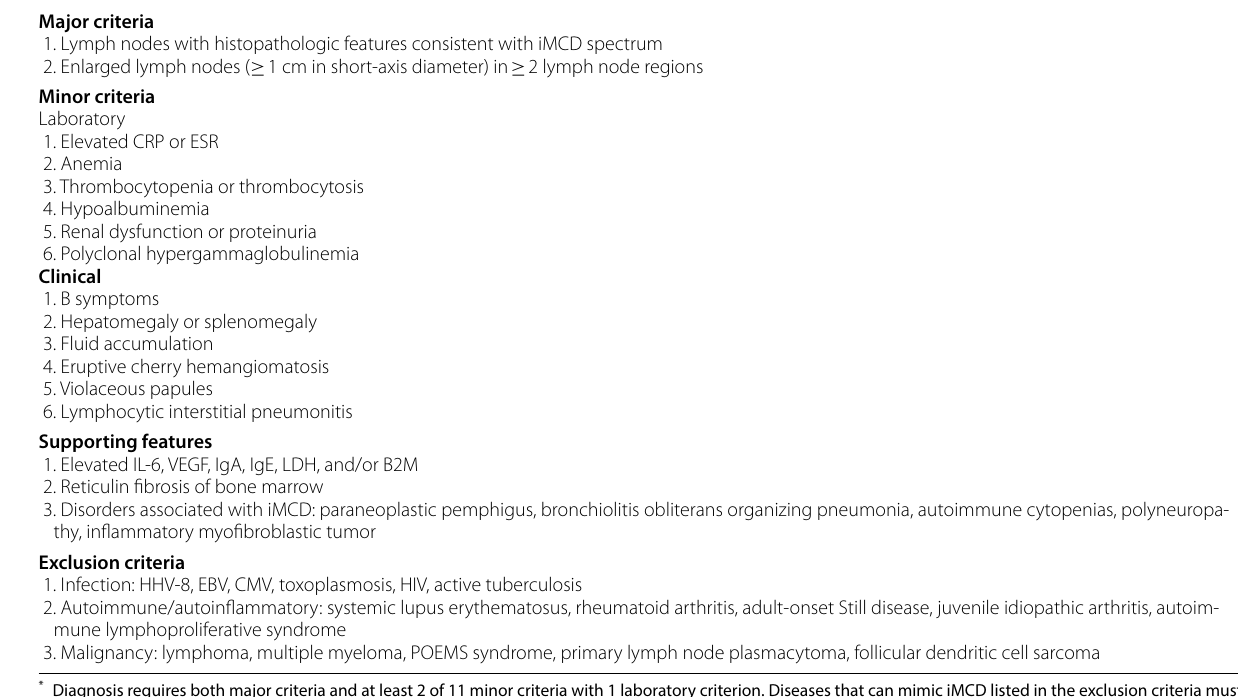
* Diagnosis requires both major criteria and at least 2 of 11 minor criteria with 1 laboratory criterion. Diseases that can mimic iMCD listed in the exclusion criteria must be ruled out iMCD, idiopathic Castleman disease; CRP, C-reactive protein; ESR, erythrocyte sedimentation rate; IL-6, interleukin 6; VEGF, vascular endothelial growth factor; IgA, immunoglobulin A; IgE, immunoglobulin E; LDH, lactate dehydrogenase; B2M, Beta-2 microglobulin; HHV-8, human herpesvirus-8; EBV, Epstein–Barr virus; CMV, cytomegalovirus; POEMS, polyneuropathy, organomegaly, endocrinopathy, monoclonal protein, skin changes)